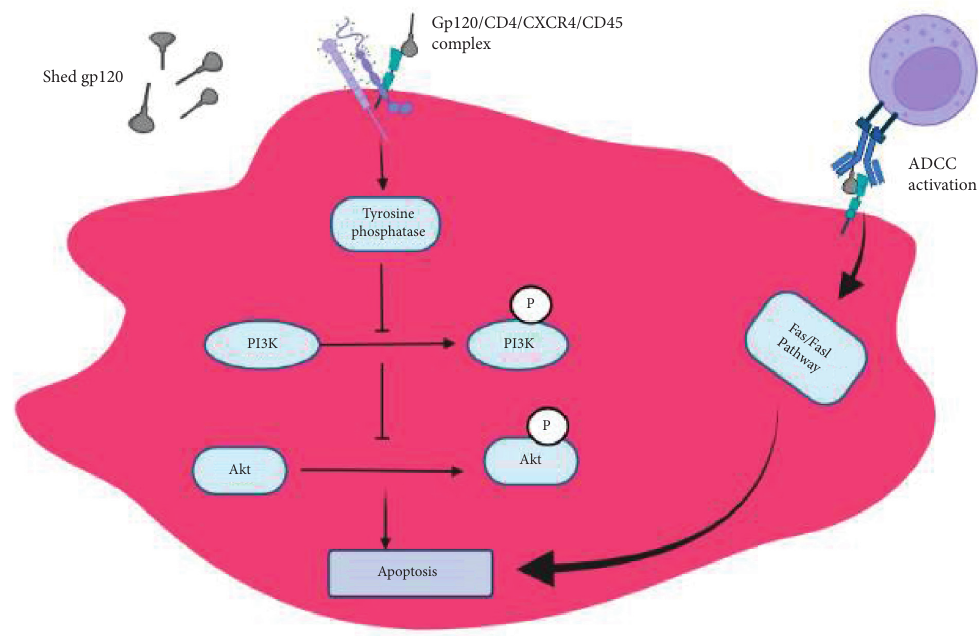
Figure 4: Role of shed gp120 in inducing inactivation of P13K/Akt pathway following the engagement of CD4+5 after gp120/CD4+ interaction. Also, as illustrated, gp120 forms a complex with CD4+, which is eventually recognized by antibodies that trigger ADCC